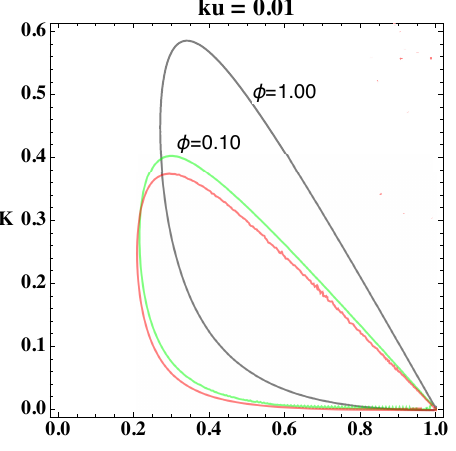
Figure 1. Diagram in parameter space of the Poincare–Andronovo–Hopf (PAH) bifurcation boundaries with k u = 0.010.